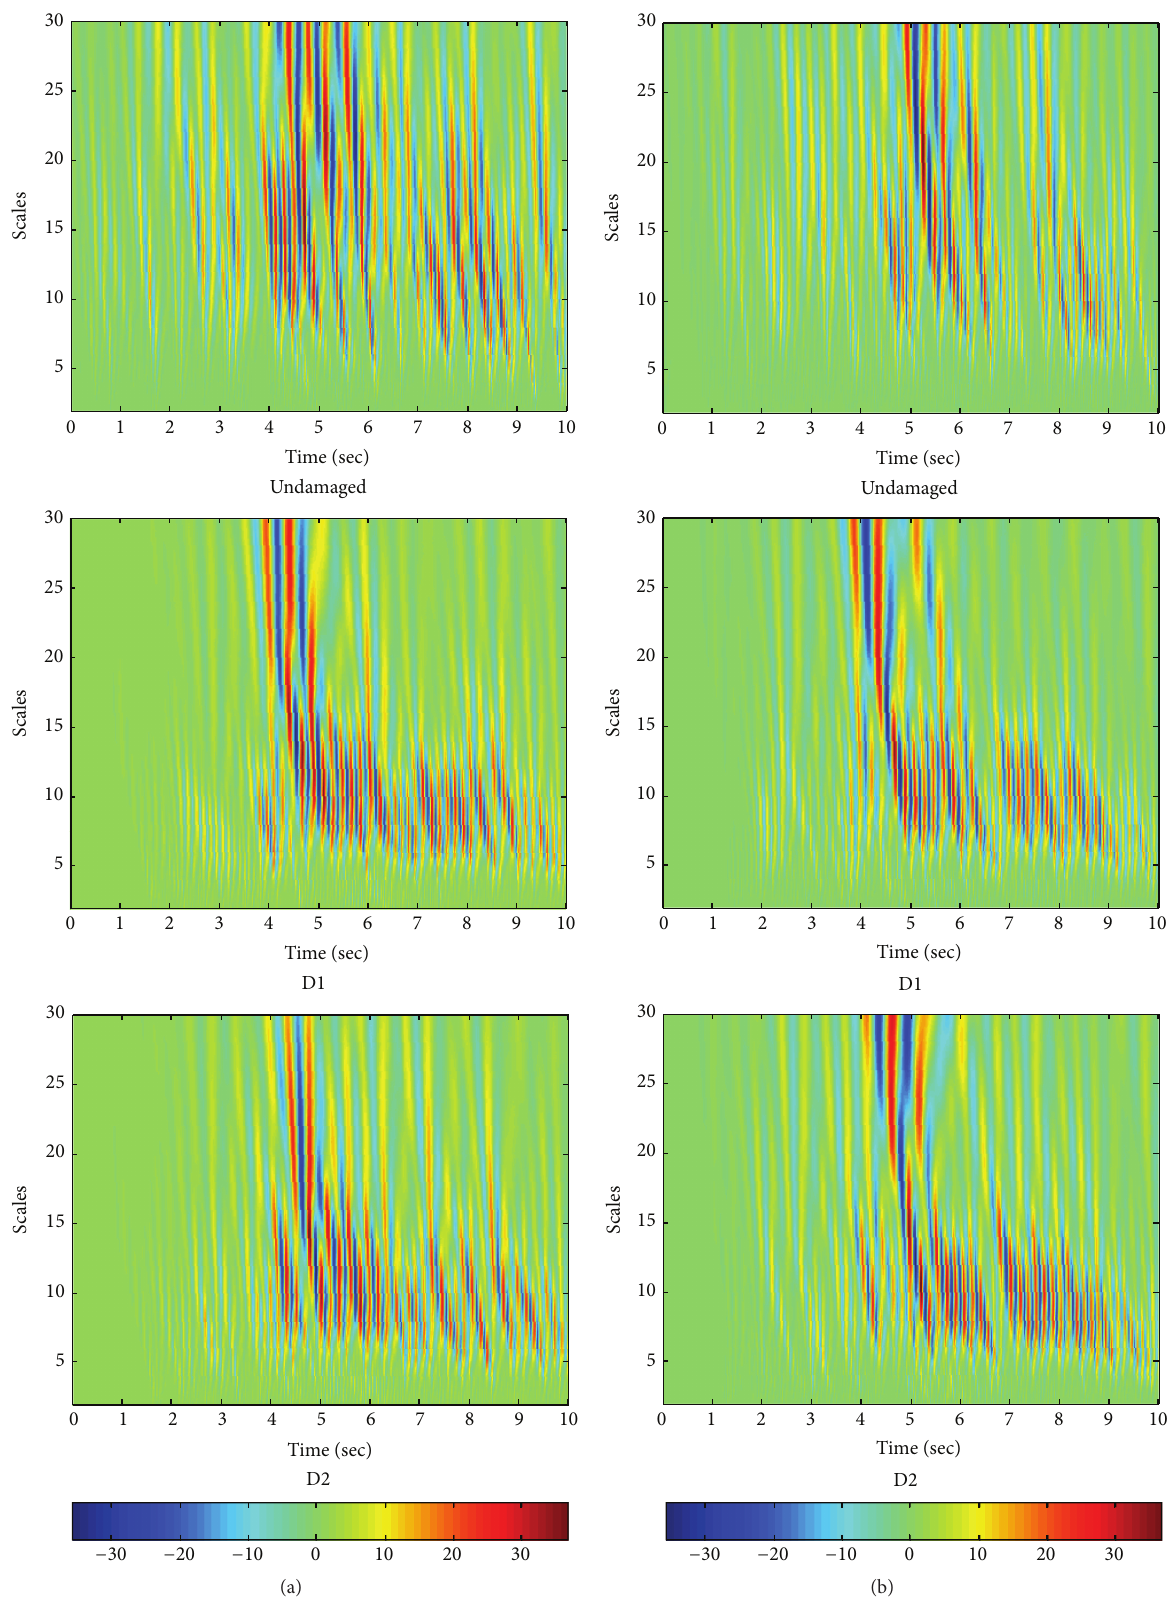
Figure 4: Continuous wavelet coefficients of F3 behavior during shaking effect for regular (a) and irregular (b)